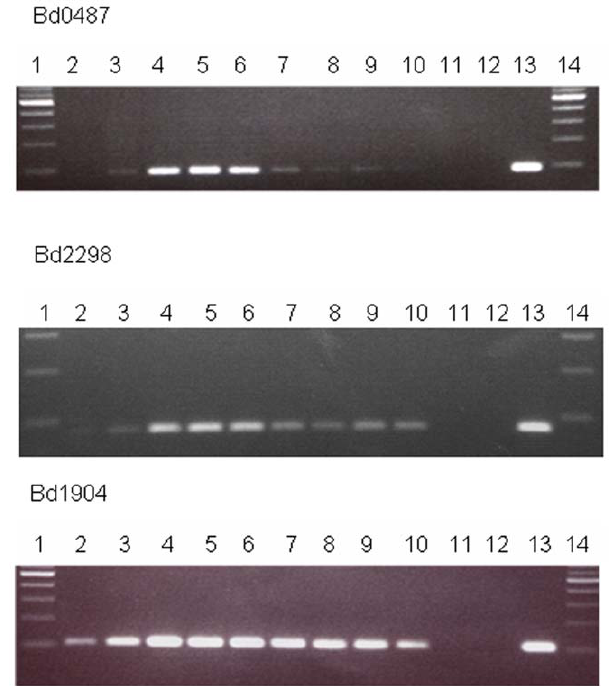
Figure 6.Transcription profiles of upregulated hypothetical genes across the predatory cycle. RT-PCR on total RNA prepared from identical volumes of B. bacteriovorus HD100 predator-prey E. coli S17-1 infection culture as the predatory infection proceeds across a time course. Primers were designed against three Bdellovibrio -specific but otherwise unknown function that specify proteins with signal sequences. These genes were shown by the array studies to be significantly up-regulated upon the shift from attack-phase to 30 minutes of predatory growth. Lanes 1 & 14 NEB 100bp ladder, 2: attack-phase 3: 15 minutes predation, 4: 30 minutes predation, 5: 45 minutes predation 6–9: 1,2,3,4 hours predation respectively 10: HI growth, 11: no template control 12: E. coli S17-1 only RNA control 13 B. bacteriovorus HD100 genomic DNA control.